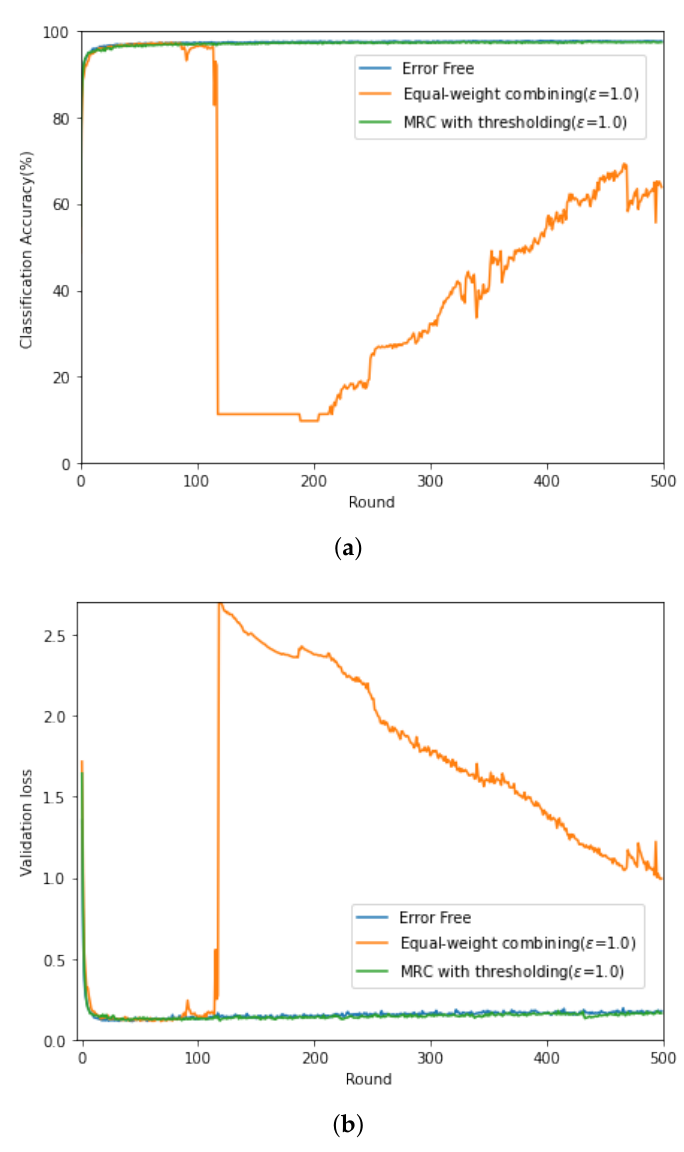
Figure 3. ( a ) Classification accuracy and ( b ) CE loss curves at SNR rec = 15